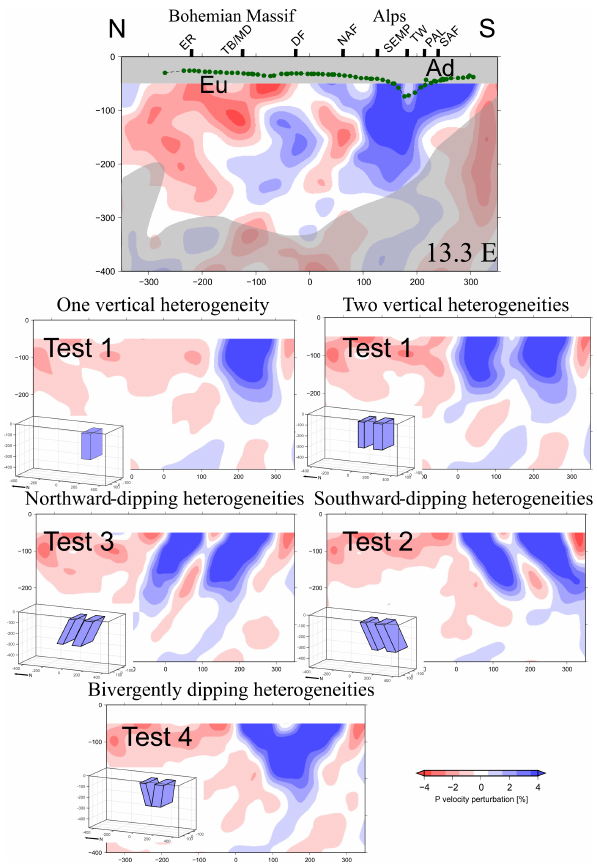
Figure 4. Synthetic tests of tomography capability to resolve one or two sub-parallel heterogeneities (TEST1) and their dip directions (TEST2, TEST3, and TEST4) in the central cross section along the EASI. The similar north–south cross sections parallel to the central EASI profile on its east and west, corresponding to profiles in Fig. 3, are in Supplement Fig. S6a–d. The along-longitude cross sections run from 51.65 to 45.35 ◦ N. Fault labels are as in Fig.